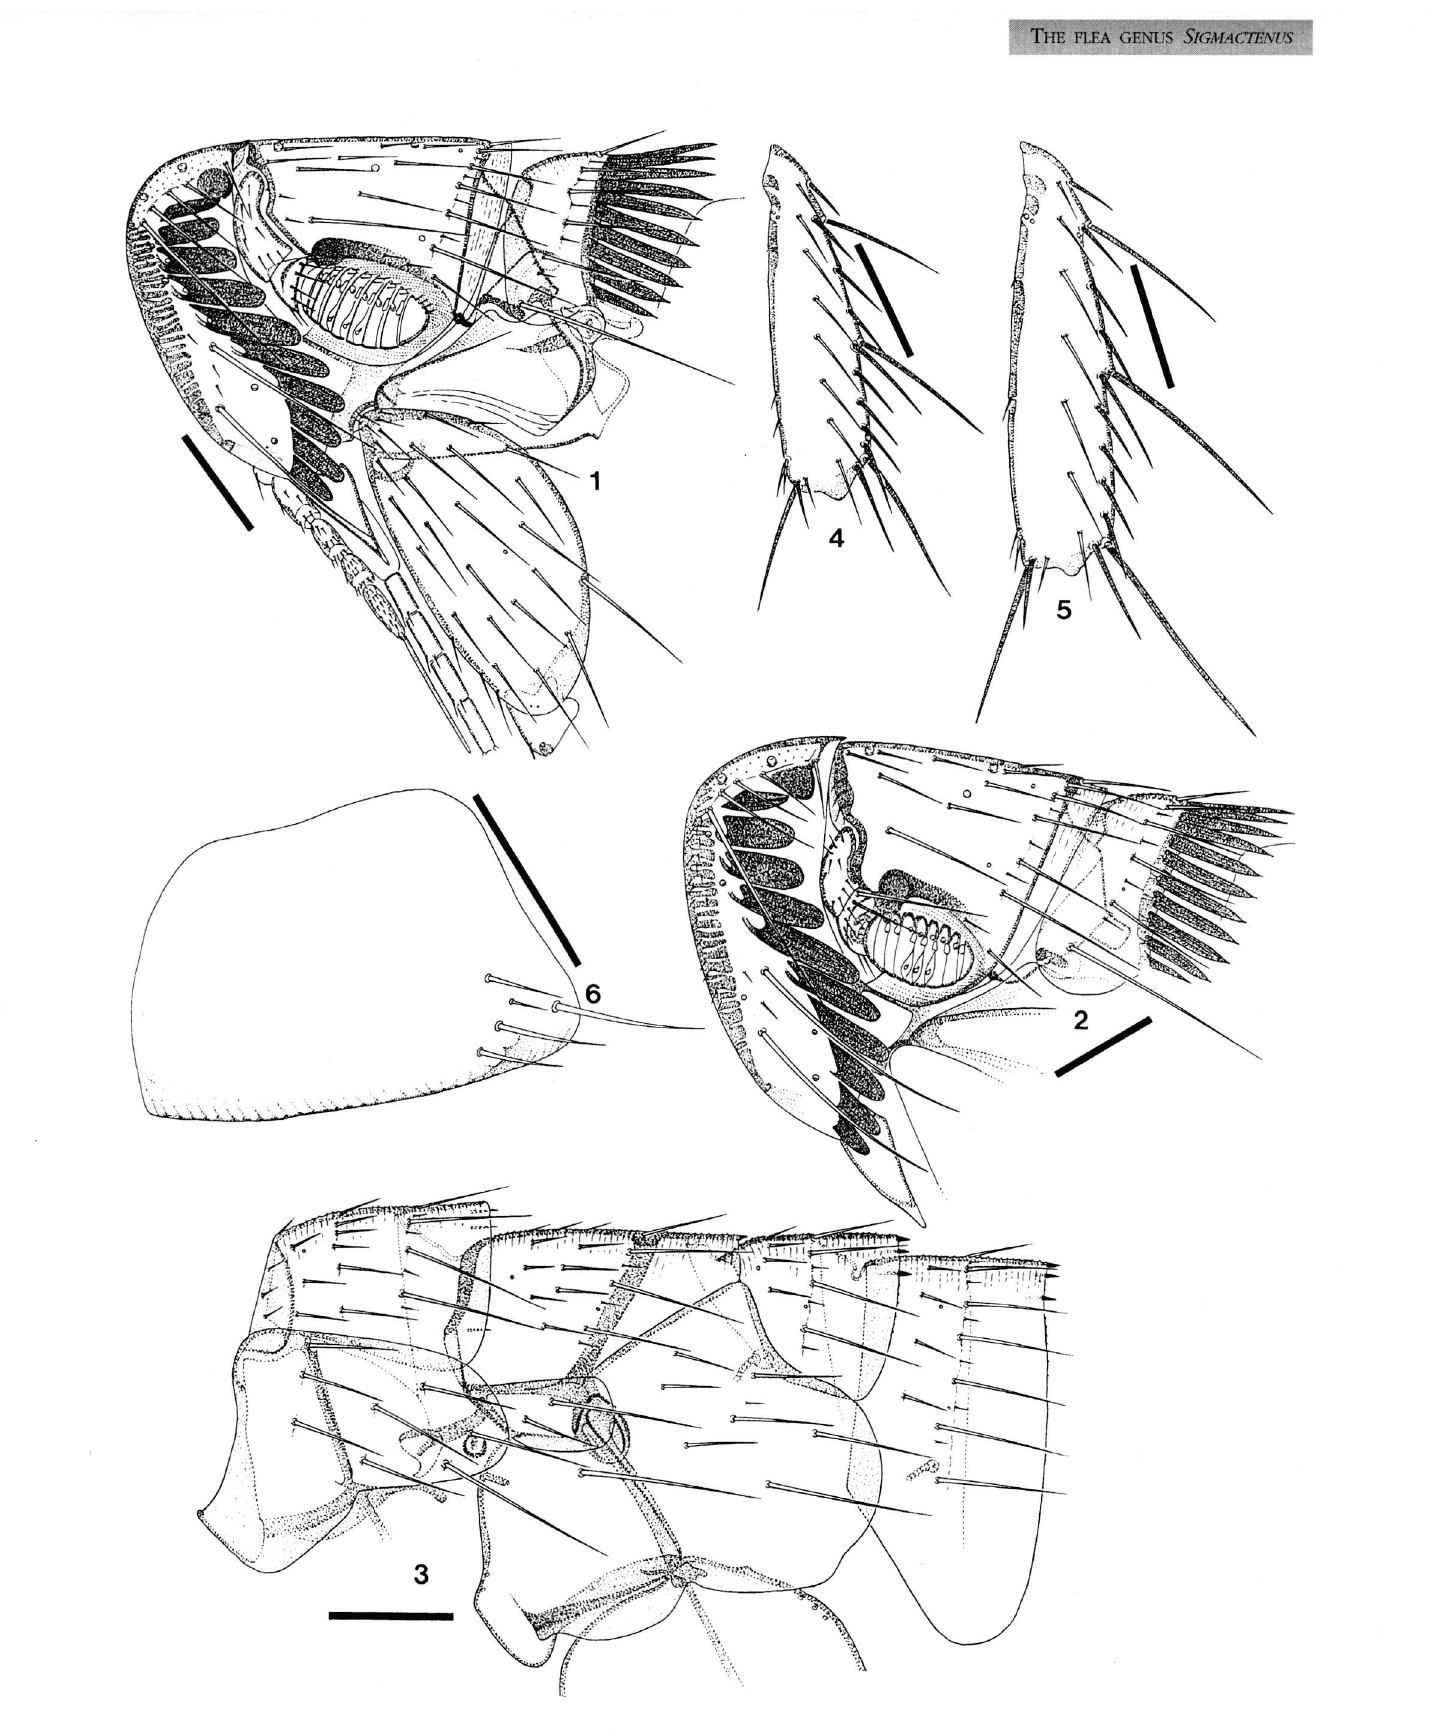
Figs 1-6. - Sigmactenus sulawesiensis n. sp. 1: Head, prothorax and adjacent structures of male. 2: Head, prothorax and adjacent struc- aires of female. 3: Thorax of female. 4: Tibia II of female. 5: Tibia III of female. 6: Tergite VIII of male. All scale bars = 0.1 mm. Parasite, 2000, 7, 151-165 Mise au point